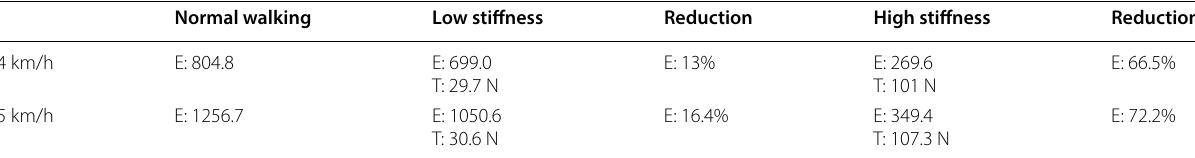
Table 2 Data comparison on EMG signals and spring